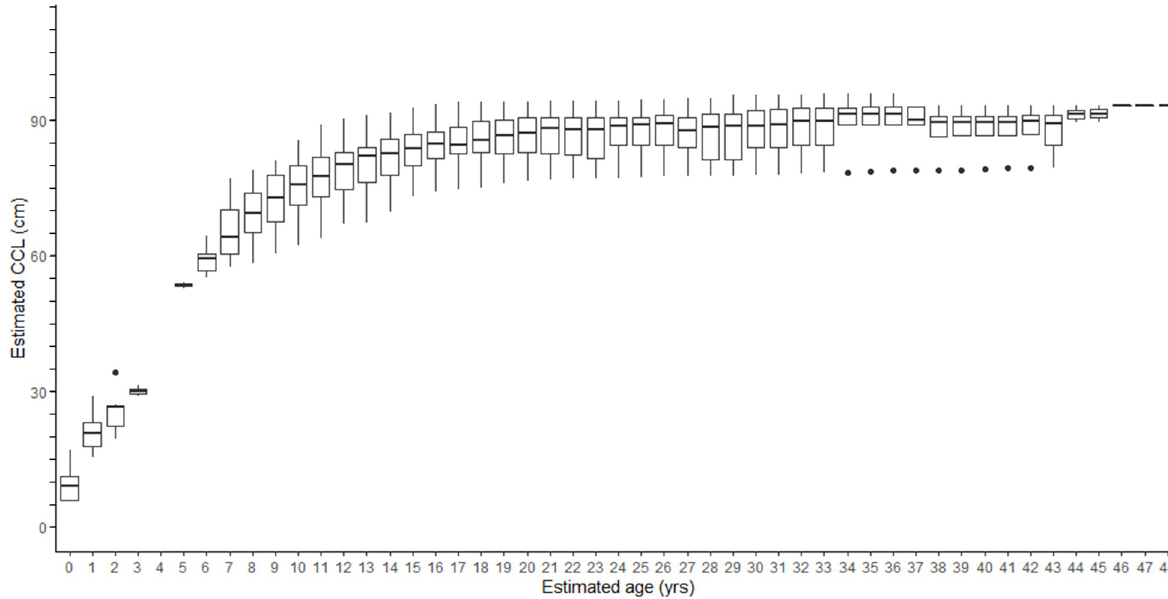
Fig 3. Flatback size-at-age. Range of estimated size (curved carapace length, CCL, cm) at each estimated age (years) for all 72 aged flatback sea turtles.